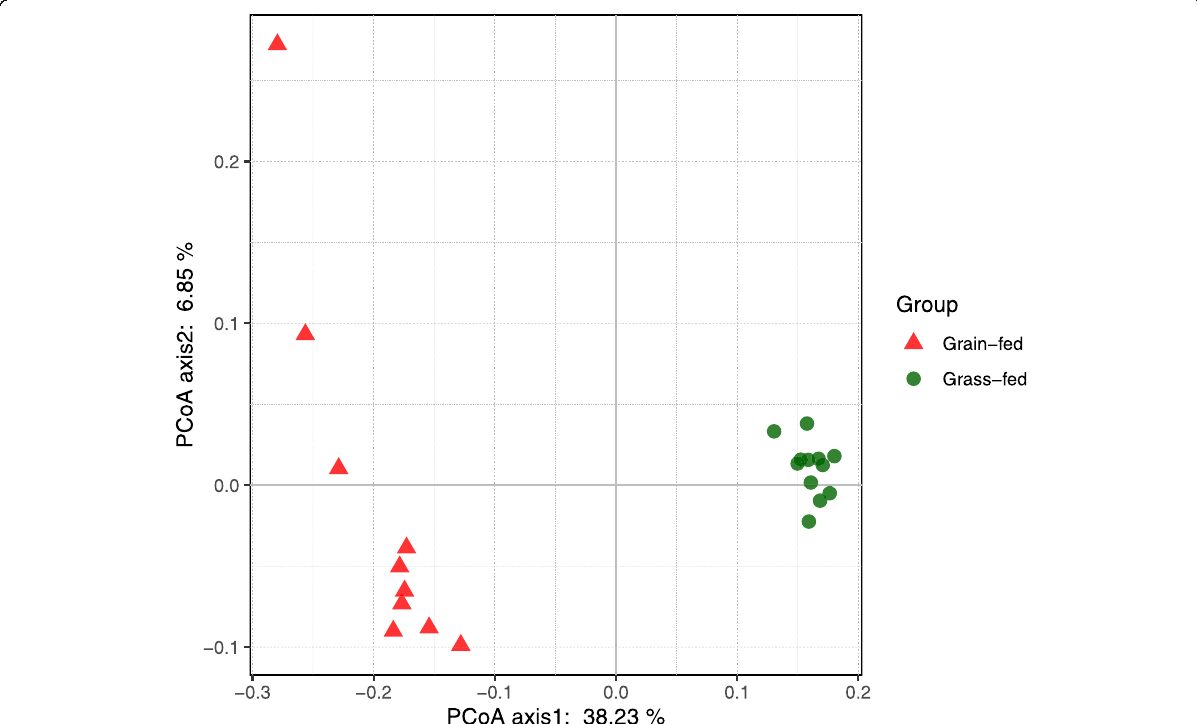
Fig. 1 The effect of the diet on beta diversity of fecal bacterial community as shown by principal coordinate analysis (PCoA) based on unweighted Unifrac distance